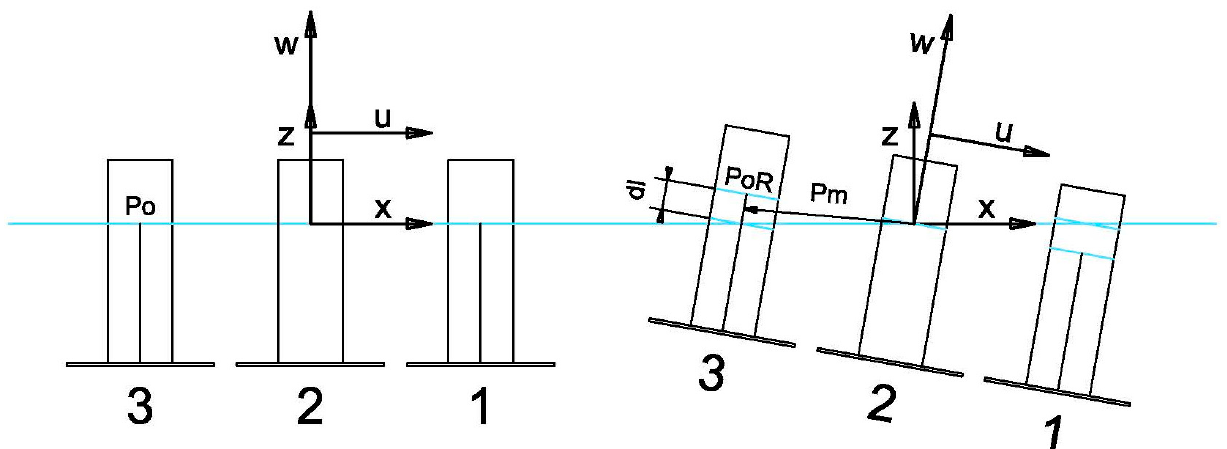
Figure 7. Loss of buoyancy scheme for cylinder 3.